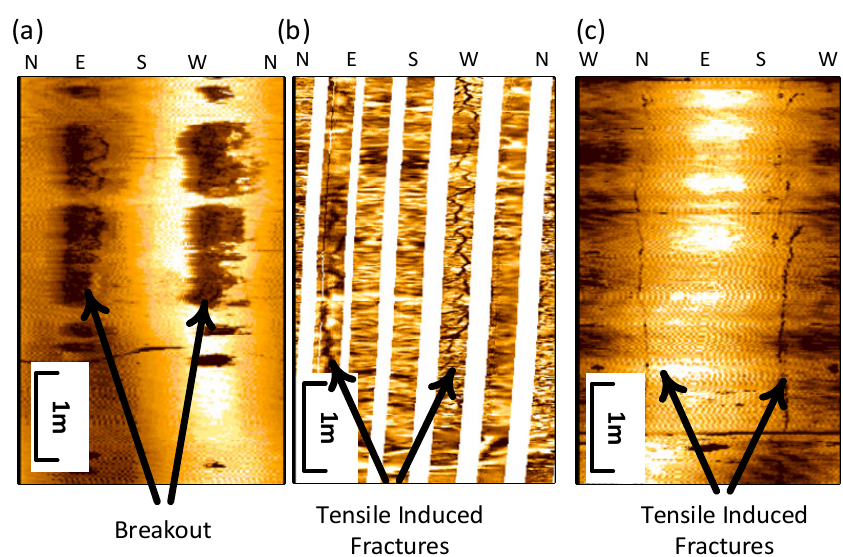
Figure 2. Examples of ( a ) borehole breakout in the E-W direction in vertical well CK-8 in the Cheshmeh-khush oil field (3460 m) and ( b ) tensile induced fracture in NE-SW direction in vertical well KH-5 in the Khesht oil field (2880 m), and ( c ) one in the N-S direction in vertical well P-2 in the Paydar oil field (3210 m). Note that for ( c ) the image started from the west (W) side of the borehole to better show two axial induced fractures at θ = 0° and θ = 180°.